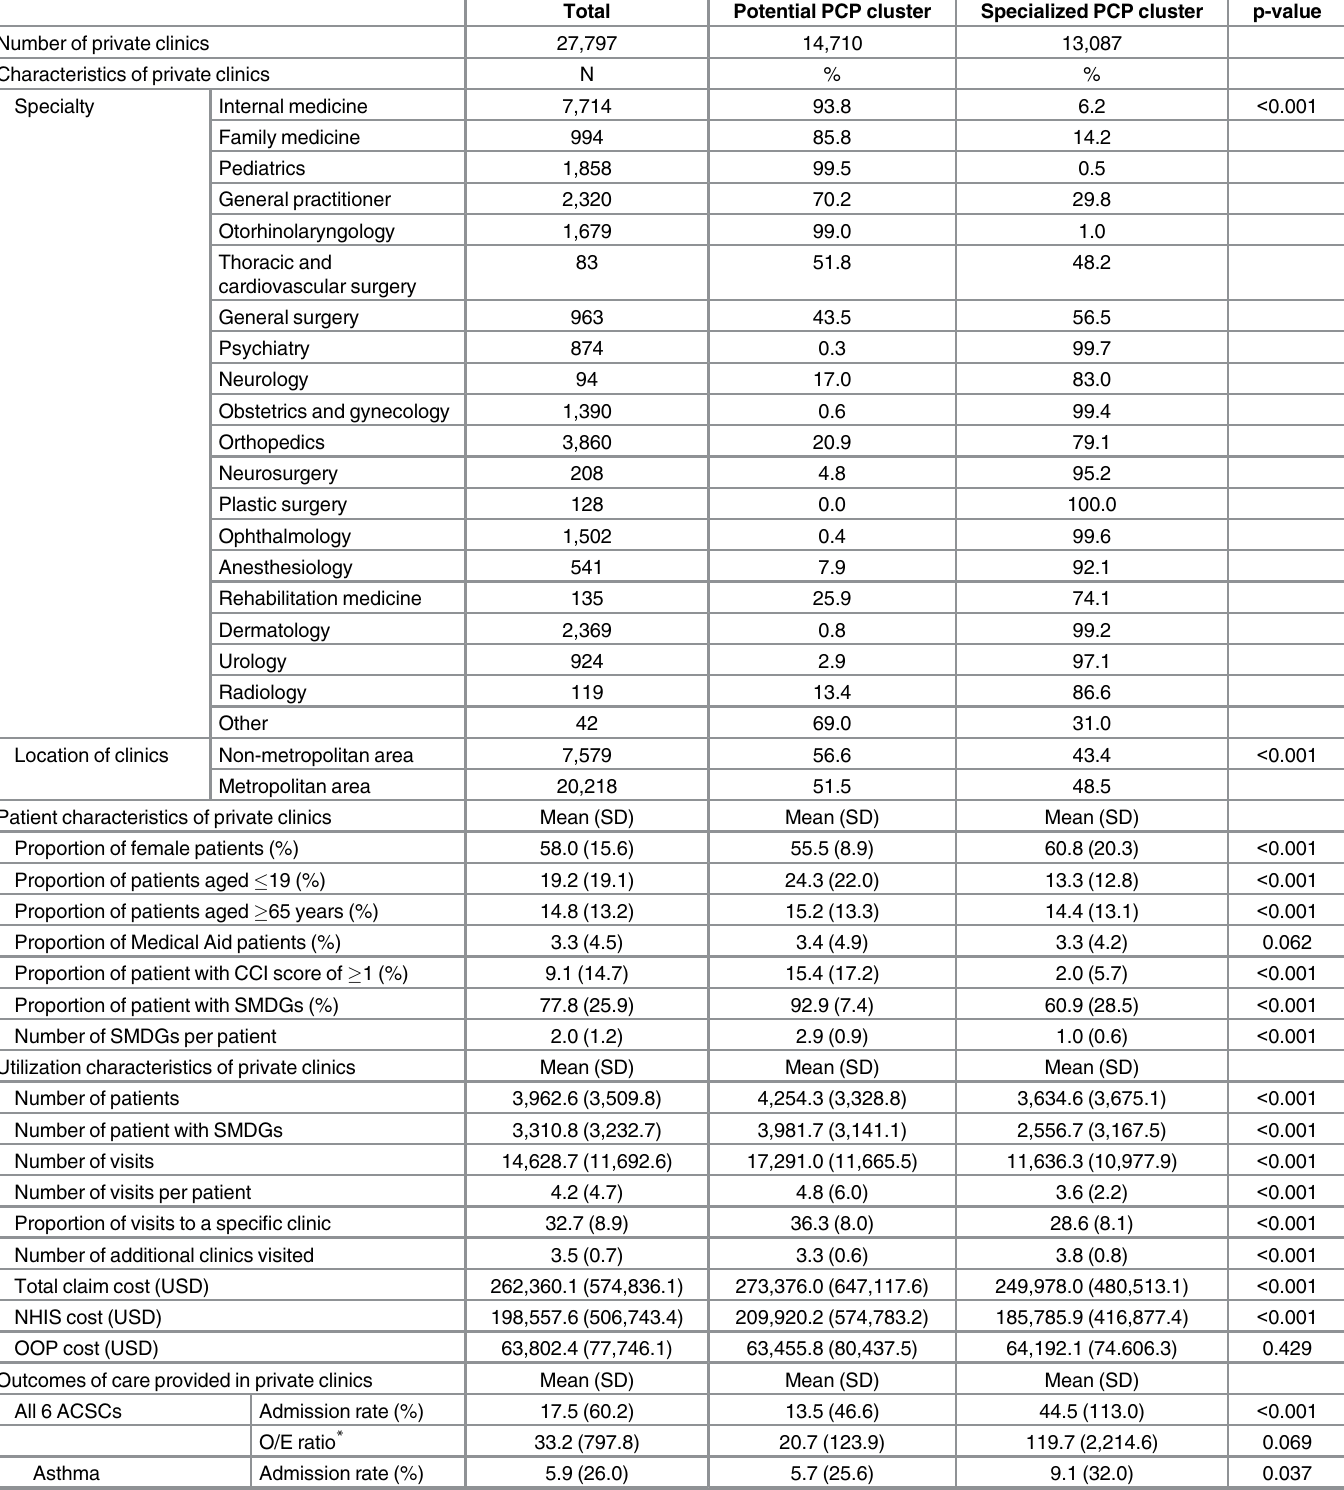
Table 2. Characteristics of the potential and specialized primary care provider